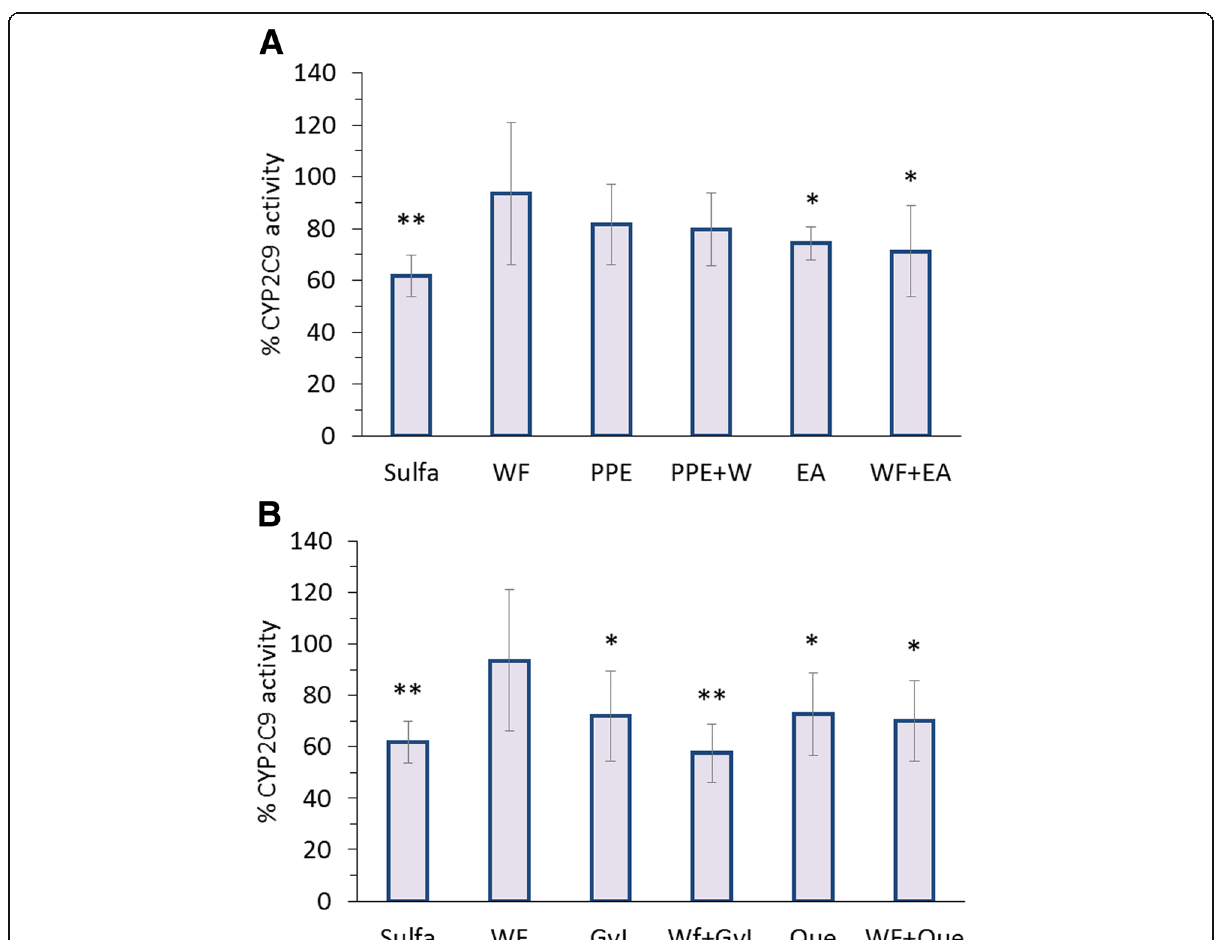
Fig. 3 Percentage of CYP2C9 activity relative to untreated isolated hepatocytes of different groups treated with sulfamethoxazole (130 μ g/ml) and warfarin (3 μ g/ml) alone or in combination with: ( a ) pomegranate peel extract (120 μ g/ml), ellagic acid (48 μ g/ml) or, ( b ) guava leaves extract (294.1 μ g/ml) and quercetin (15 μ g/ml). Each data point represents the mean ± SD ( n = 6). Statistical evaluation was performed by comparing the percentage of activity of untreated cells with treated cells *p < 0.05, **p <